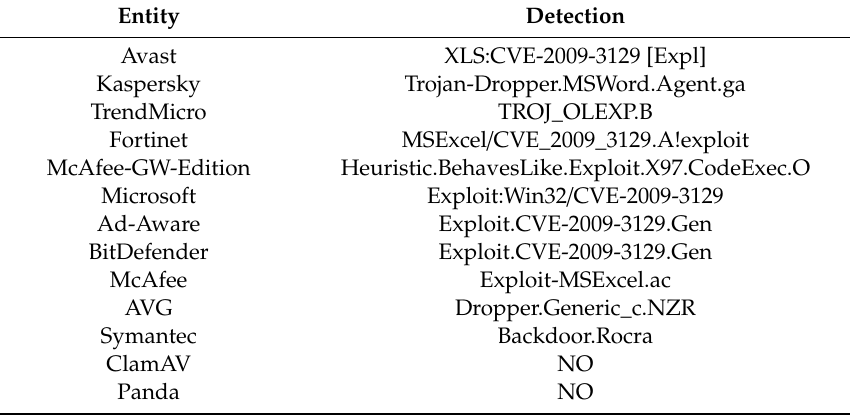
Table 8. Antivirus